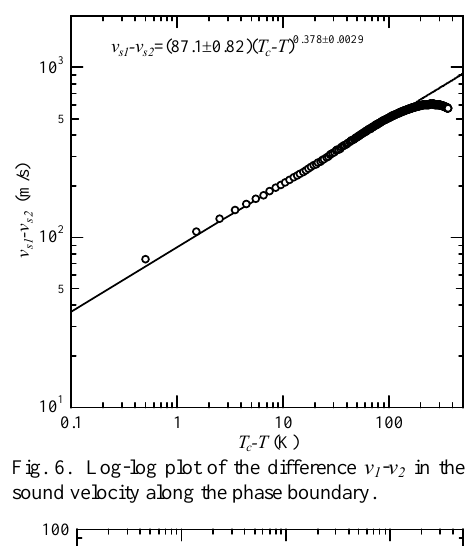
Fig. 4. Phase diagram of Sb-Sb2S3. A small bar is the boundary obtained from the magnetic susceptibility measurements. changed by 5 at.% of